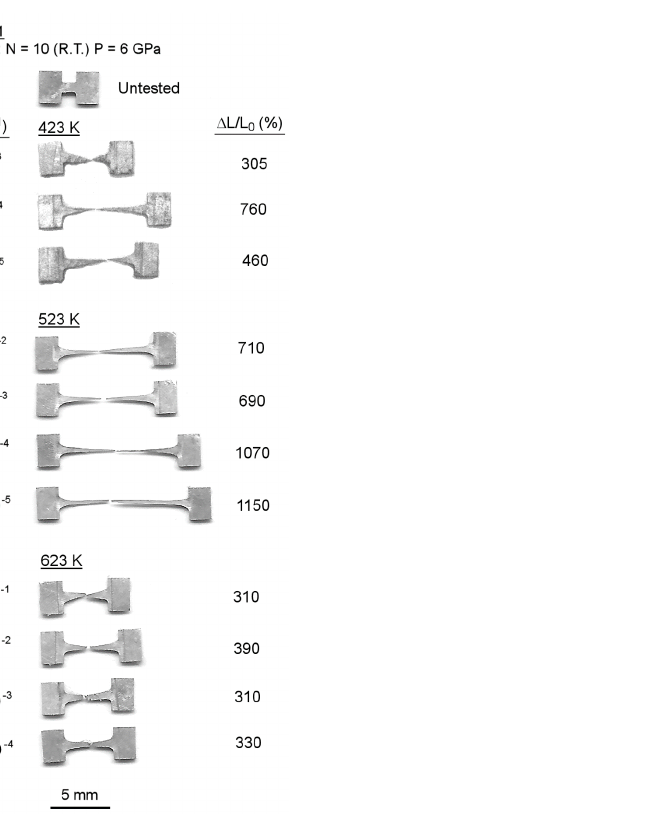
Figure 2. Appearance of tensile specimens pulled to failure at different temperatures and strain rates.